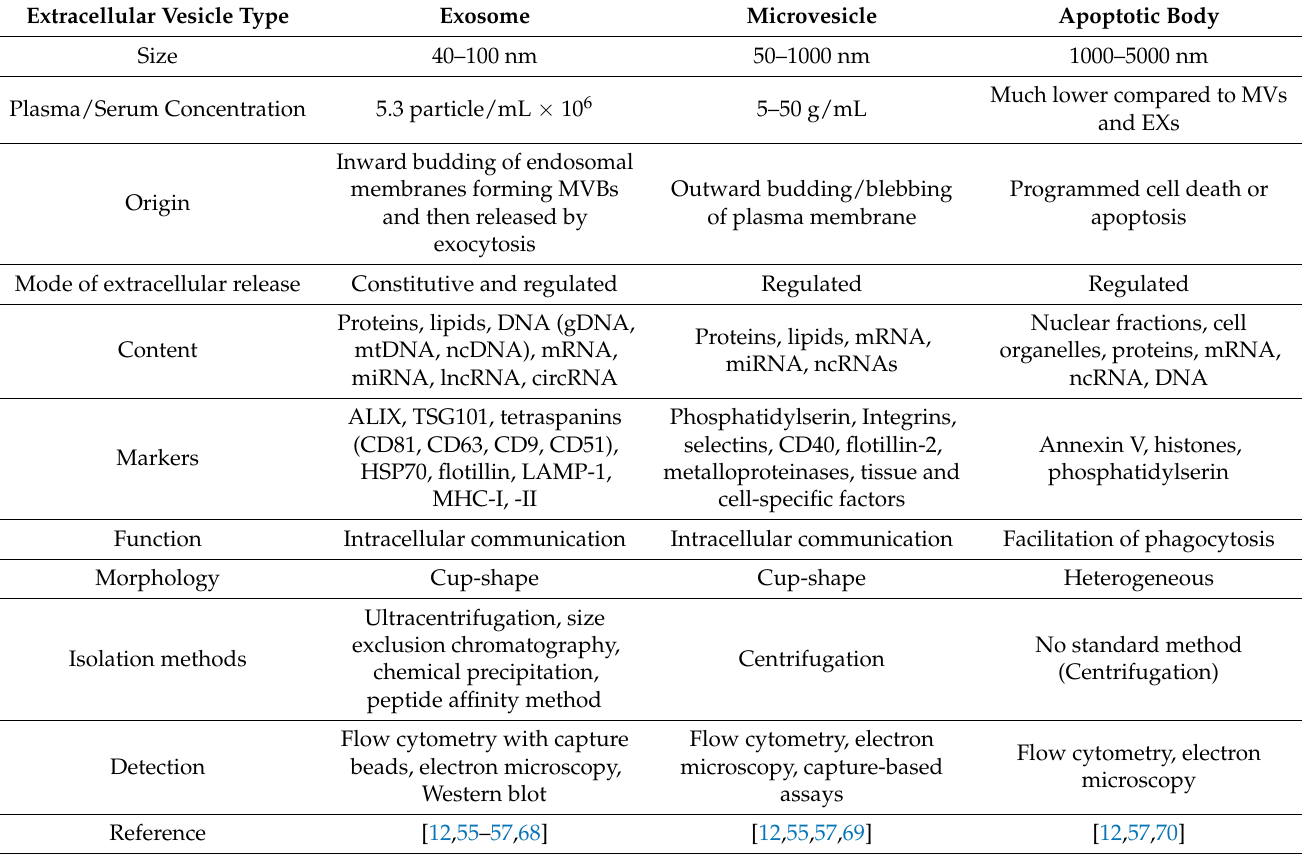
Table 1. Characterization of extracellular vesicles from different